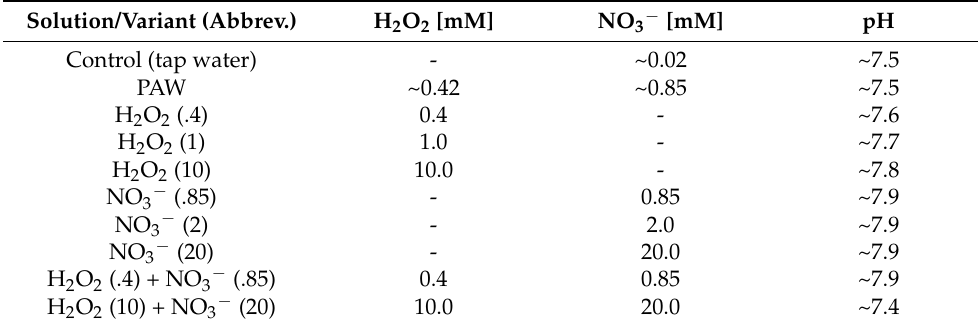
Table 1. Chemical composition and pH of plasma activated water (PAW) and various H 2 O 2 /NO 3 − solutions. The respective concentrations are indicated in parentheses in abbreviated format that is used in text and